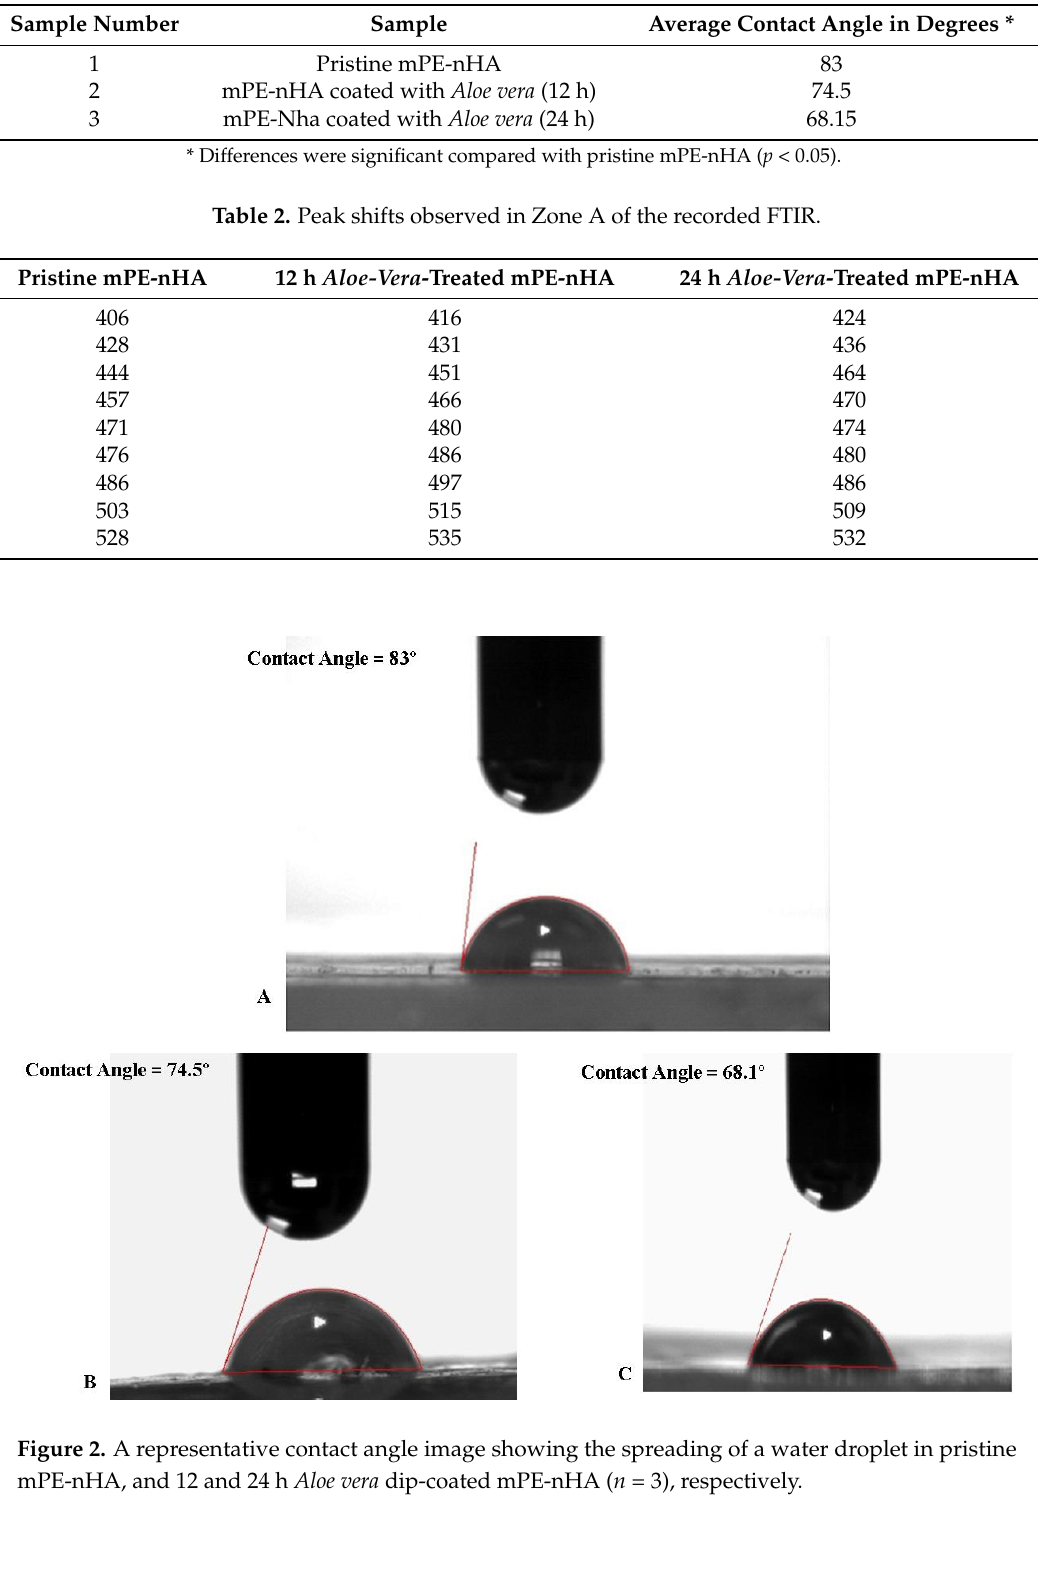
Figure 3. A representative FTIR spectra of pristine mPE ‐ nHA, 12 and 24 h Aloe vera dip ‐ coated mPE ‐ nHA nanocomposites. ( a ) 714 cm − 1 , ( b ) 1014 cm − 1 , ( c ) 1232 cm − 1 , ( d ) 1369 cm − 1 , ( e ) 1469 cm − 1 , ( f ) 1583 cm − 1 , ( g ) 1731 cm − 1 , ( h ) 2845 cm − 1 , ( i ) 2912 cm − 1 , ( j ) 3363 cm − 1 .